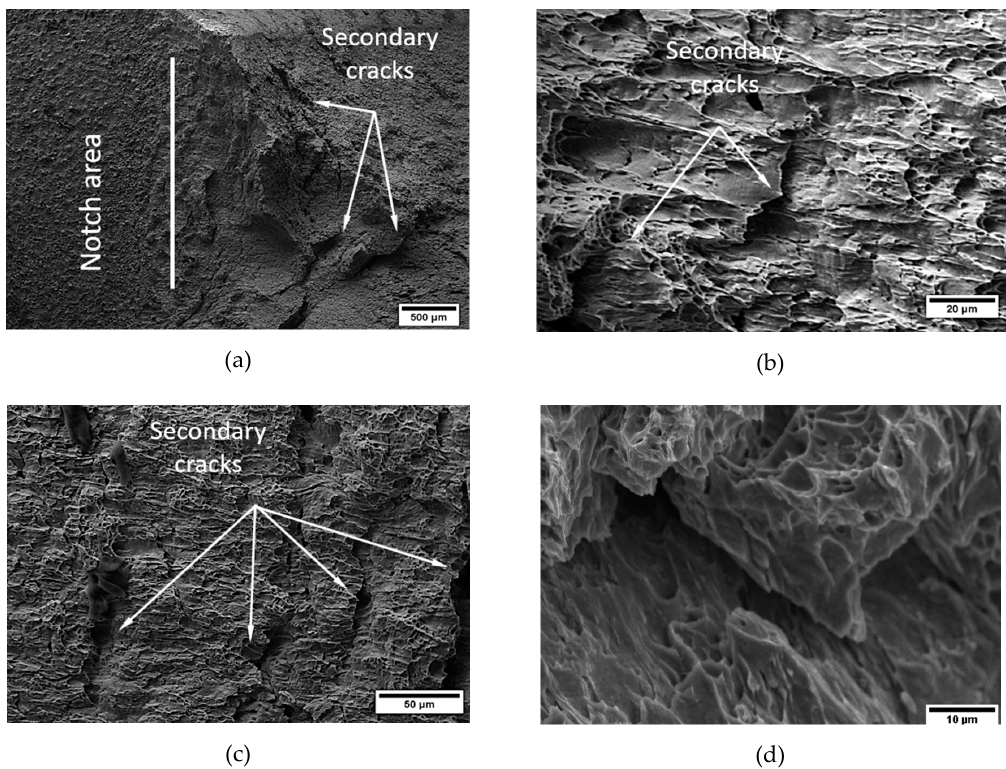
Figure 13. ( a ) Macro-level secondary cracks, ( b , c ) micro-level secondary cracks, ( d ) enlarged view of secondary cracks.